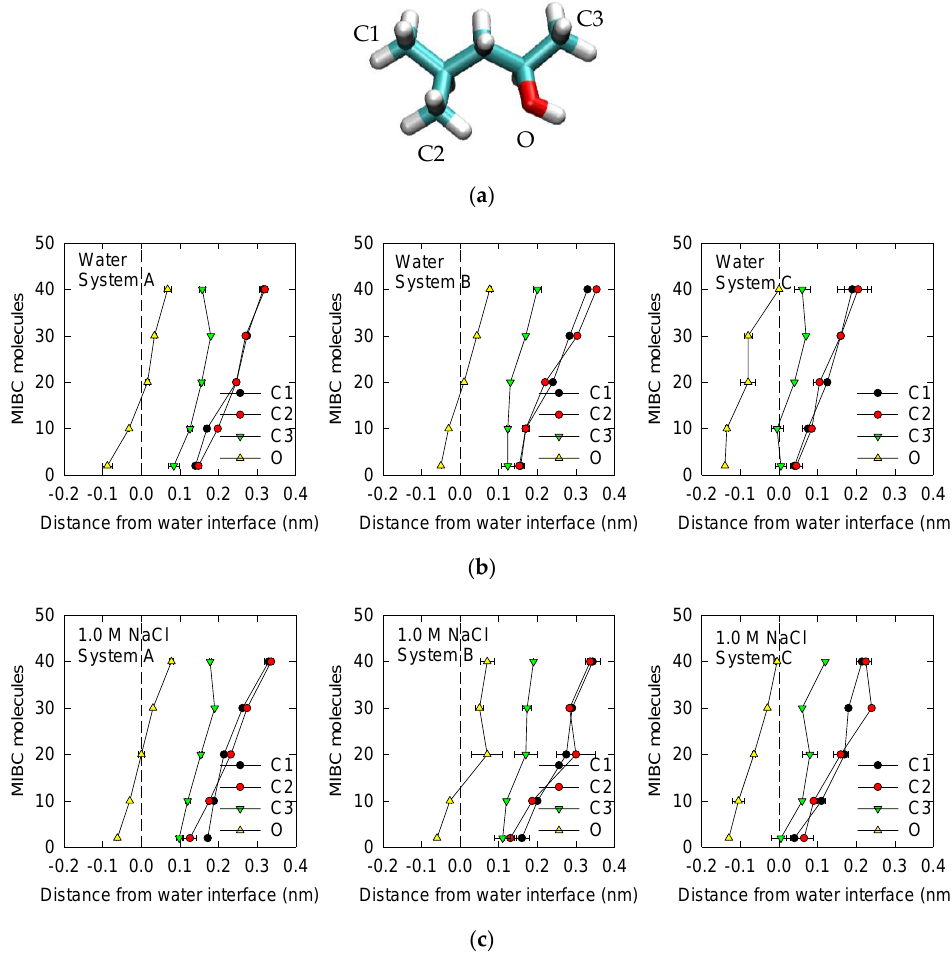
Figure 3. MIBC model indicating atom types, carbons (C1, C2 and C3) and oxygen (O) ( a ). Average position of MIBC molecules as represented by the constituent atoms with respect to the water liquid– vapor interface in water ( b ) and in 1 M NaCl ( c ) for the three systems of interest (Table 2). Negative distances correspond to liquid phase. Results correspond to the average of 10 simulations for each concentration of MIBC ranging from 2 to 40 molecules.